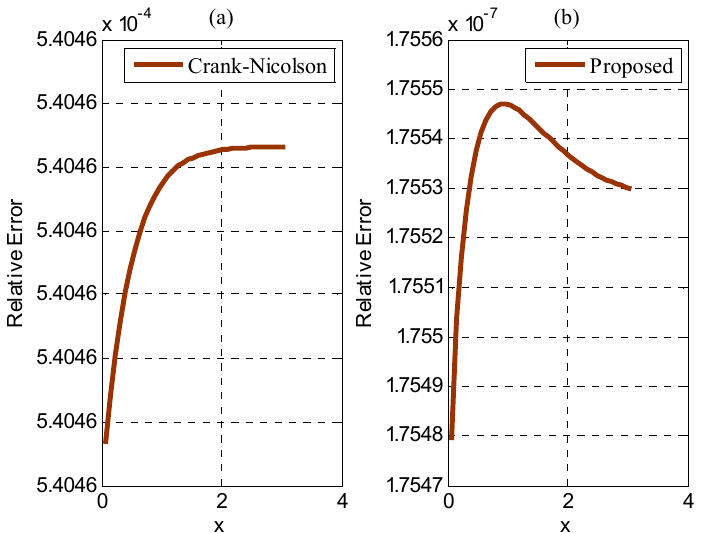
Figure 2. Comparison of two schemes over spatial coordinate using N x = 40, N t = 520, L = π , t f = 1. ( a ) Crank–Nicolson; ( b ) Proposed.